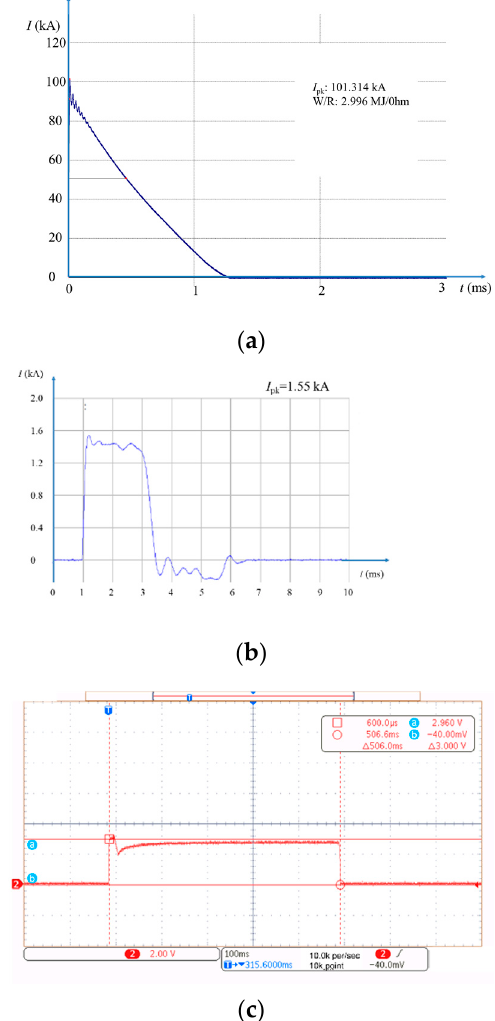
Figure 3. Three components of lightning current, ( a ) lightning current component A, ( b ) lightning current component B, ( c ) Lightning current component C.